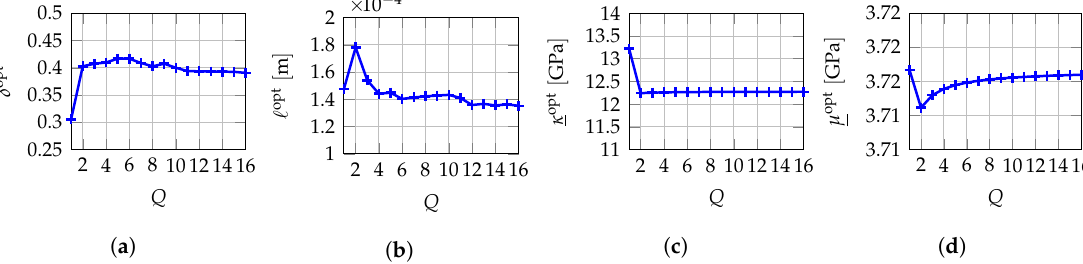
Figure 4. Fixed-point iterative algorithm: evolutions of the identified global optimal values δ opt , (cid:96) opt , κ opt and µ opt with respect to the number Q of mesoscopic domains of observation considered. ( a ) δ opt ( Q ) ; ( b ) (cid:96) opt ( Q ) ; ( c ) κ opt ( Q ) ; ( d ) µ opt ( Q ) .